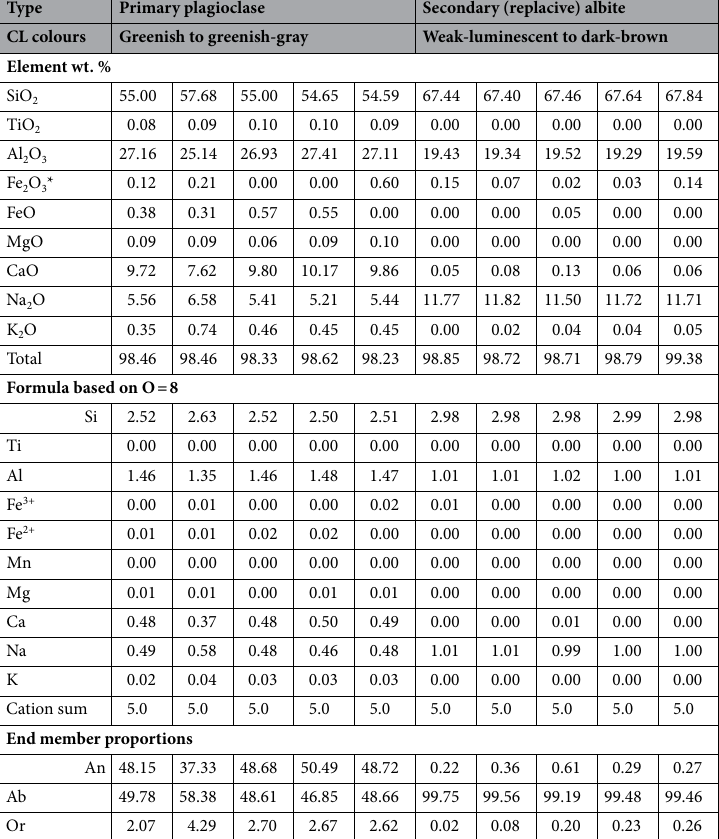
Table 4. Representative composition (EMPA) of fluorapatite from the samples with variable alteration degrees (based on 26 oxygens following the procedure proposed by 85 . The crystals oriented with their c -axes perpendicular to the incident electron beam were selected for the analyses to reduce the accumulation of halogens close to the mineral surface (see e.g. 86 ). However, a slight and local excess of halogens (> 2.0 a.p.f.u.) was occasionally presented. The areas showing both yellowish and pinkish CL colours have been investigated individually, but they turned to present a similar distribution of particular elements. *Note that Fe 2 O 3 was calculated from charge